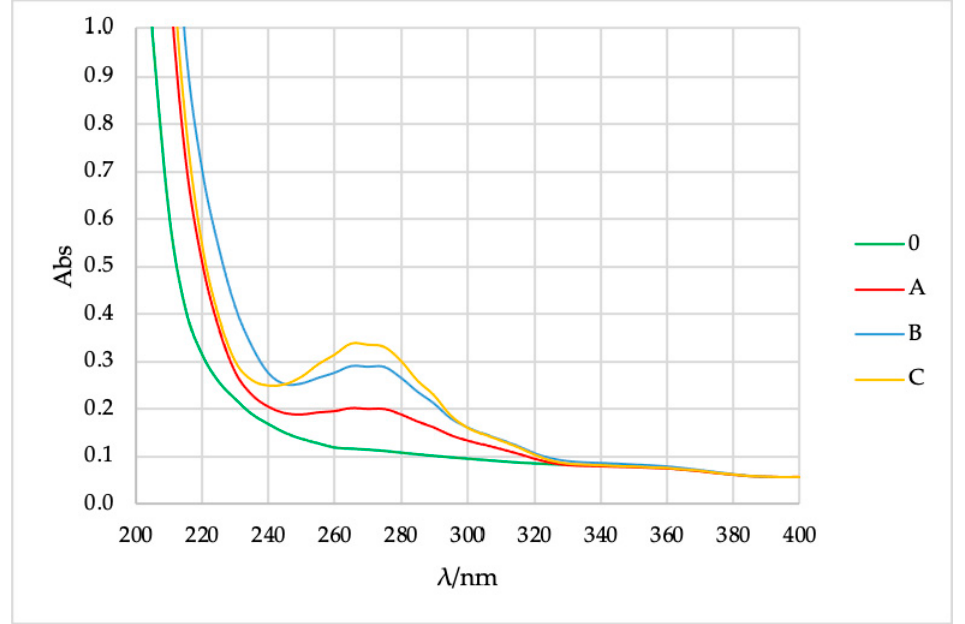
Figure 4. The absorbance of immortelle EO in microcapsules, varying amount of oil.